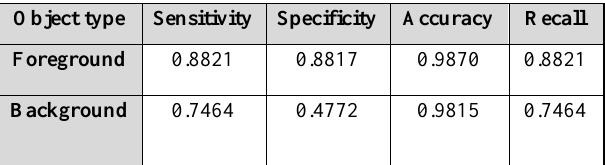
Table 1. Evaluation of object detection based on background subtraction